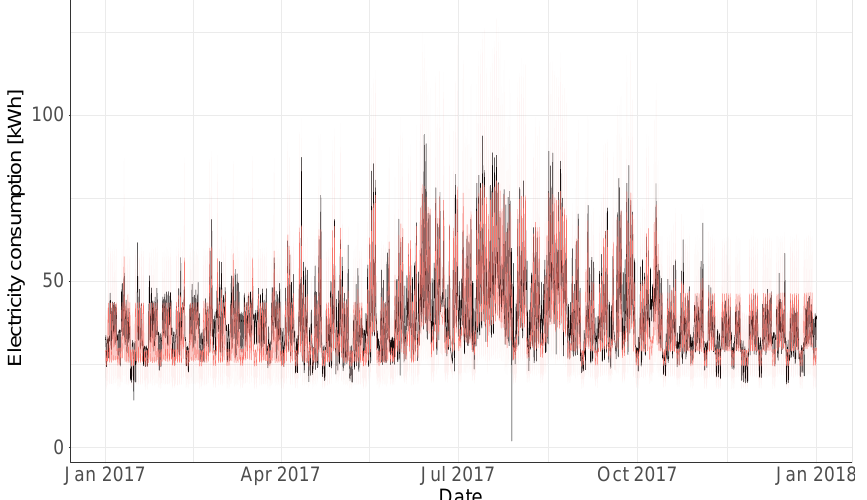
Figure 13. Test year metered electricity time-series (in black) and model predictions (in red) for Rat_health_Gaye .